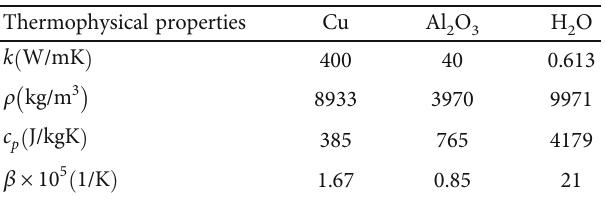
Table 2: Cu thermophysical properties along with Al [12].